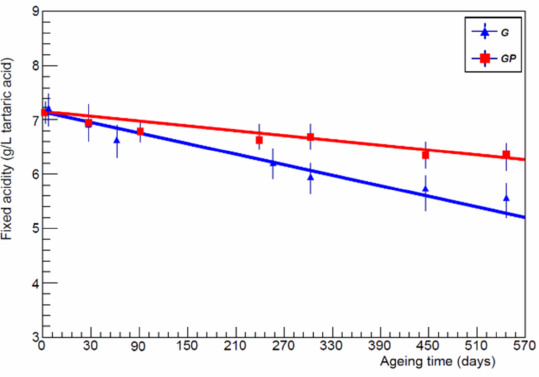
Figure 4. Fixed acidity trend as a function of the aging time (days) for each vineyard and in both protocols.